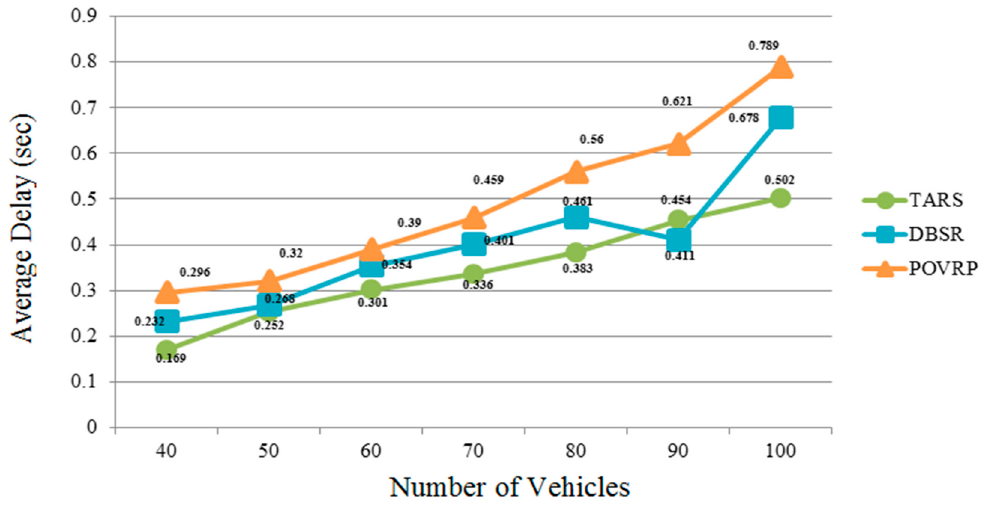
Figure 12. Average Delay in the highway